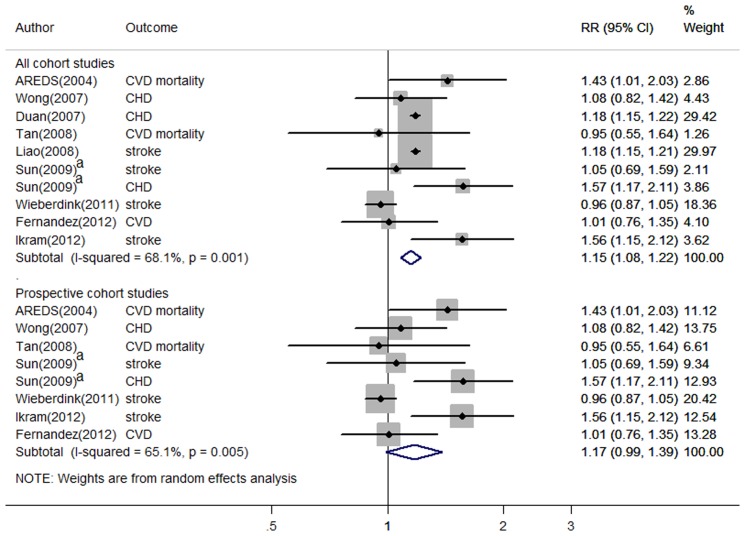
Relative risks of total CVD associated with early AMD.Top panel represents forest plot among all relevant cohort studies. Bottom panel represents forest plot among all relevant prospective cohort studies. Open data markers indicate the adjusted RR of CVD comparing persons with early AMD to persons without early AMD. The size of the data markers represents the weight of the study. Diamond indicates the pooled RR. a The study evaluated CHD and stroke separately without providing an overall RR for total CVD.